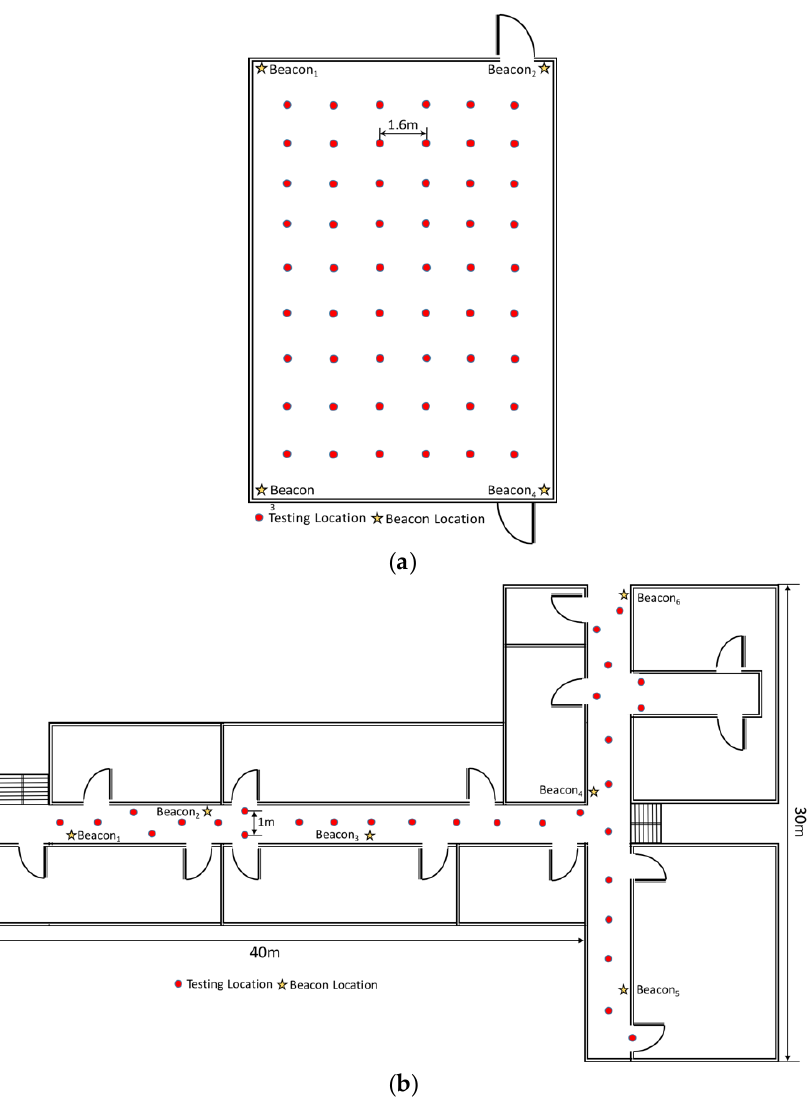
Figure 6. The two environments of field experiment. ( a ) field experiment at 30 m × 30 m square area; ( b ) field experiment at two corridors with 40 and 30 m lengths.